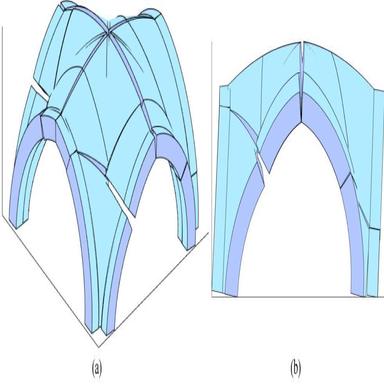
Collapse mechanism for the unreinforced vault. (a) Perspective and (b) lateral views.